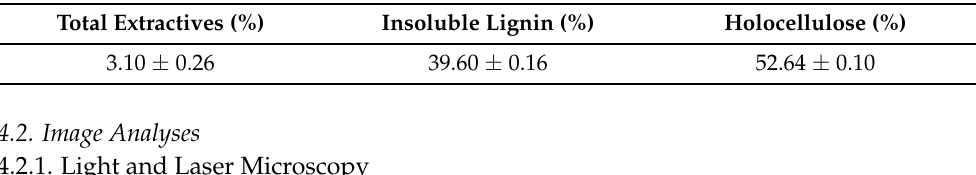
Table 7. Chemical composition of the crushed